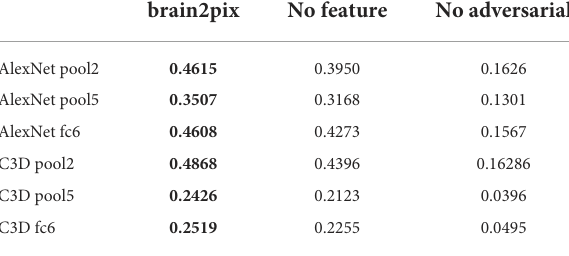
TABLE 5 Ablation experiment correlations values .